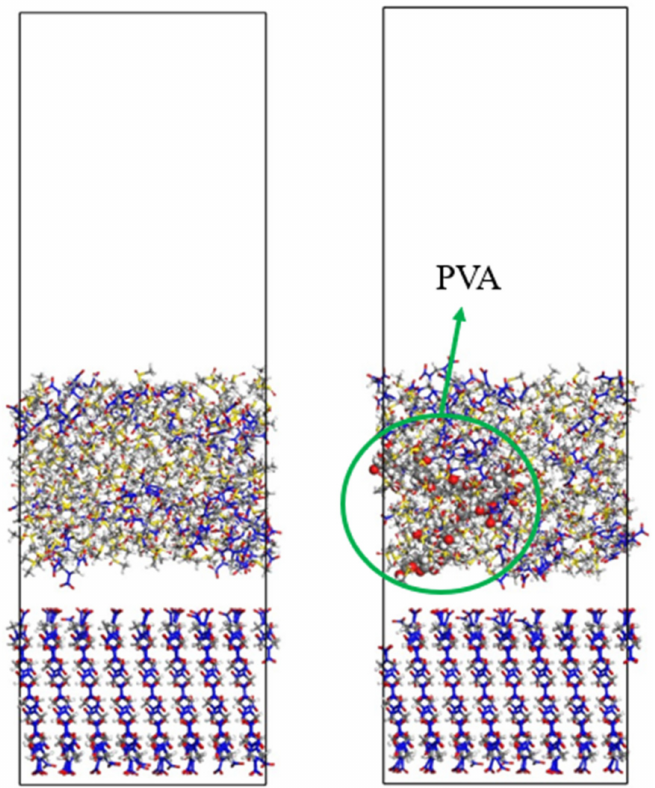
Figure 10. Modeling process of the effect of additives on solvent and solute movement in the crystallization